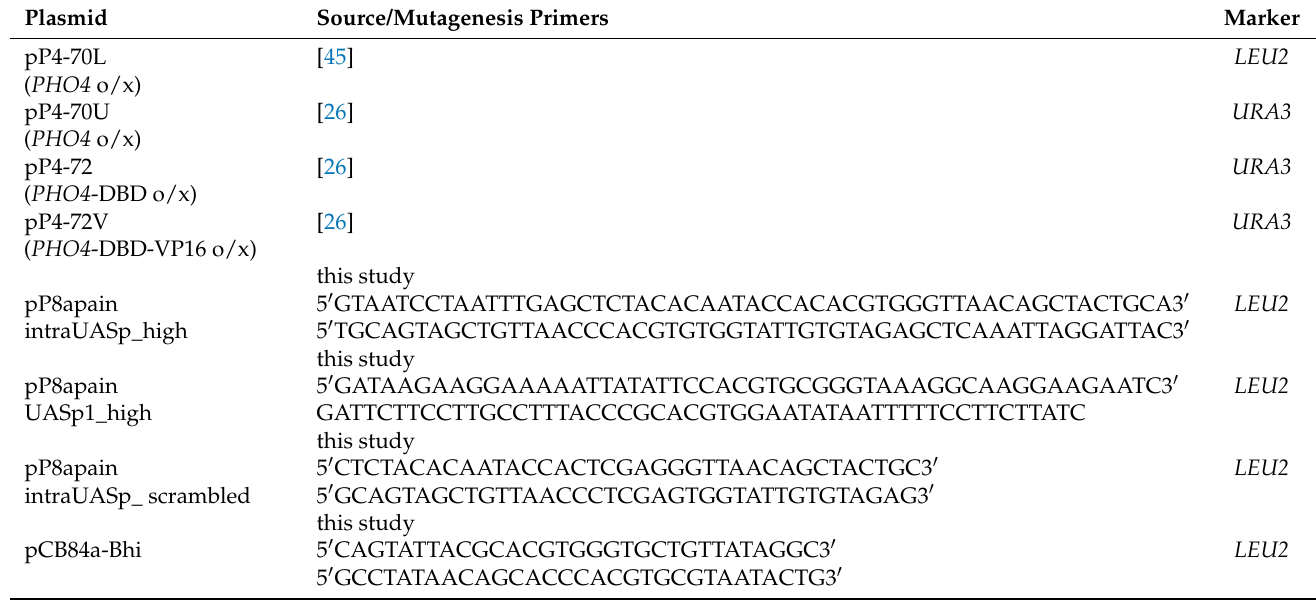
Table 3. Plasmids and primers used in this